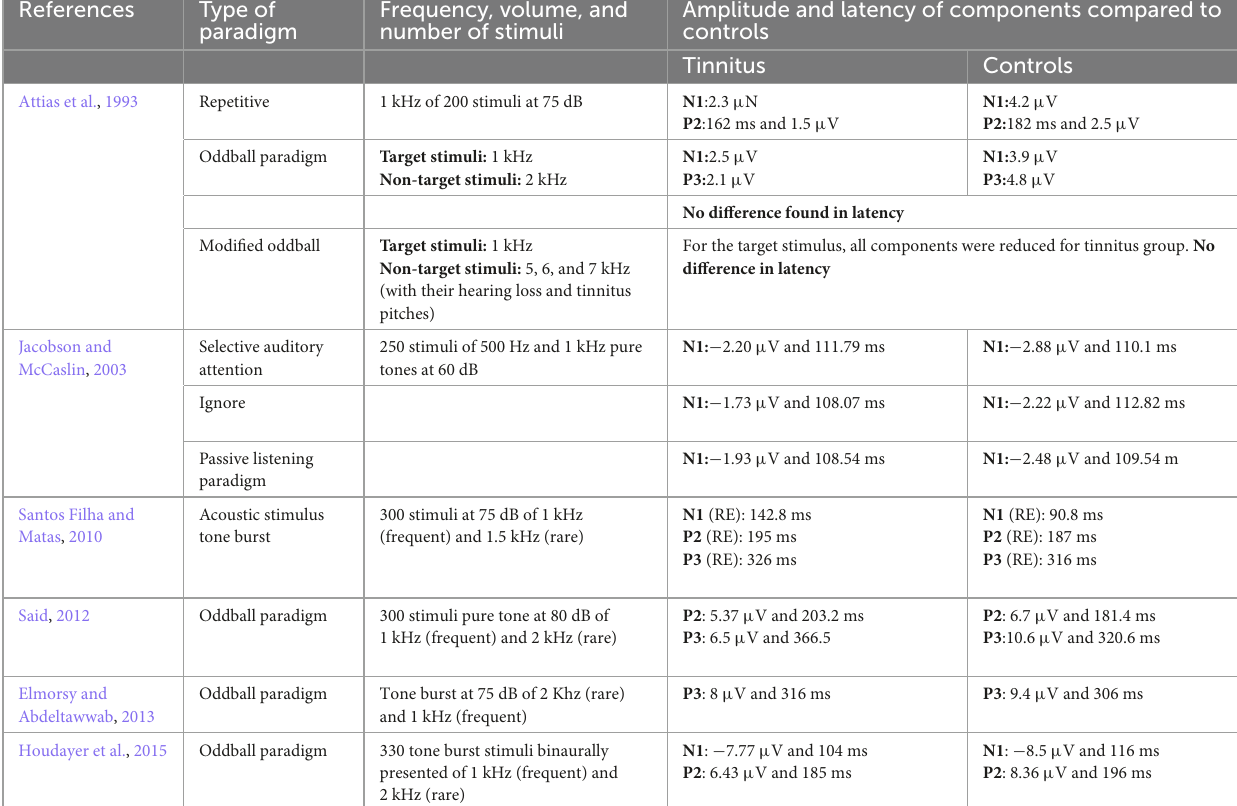
TABLE 1 Comparison of amplitudes and latencies of AERP components between controls and tinnitus